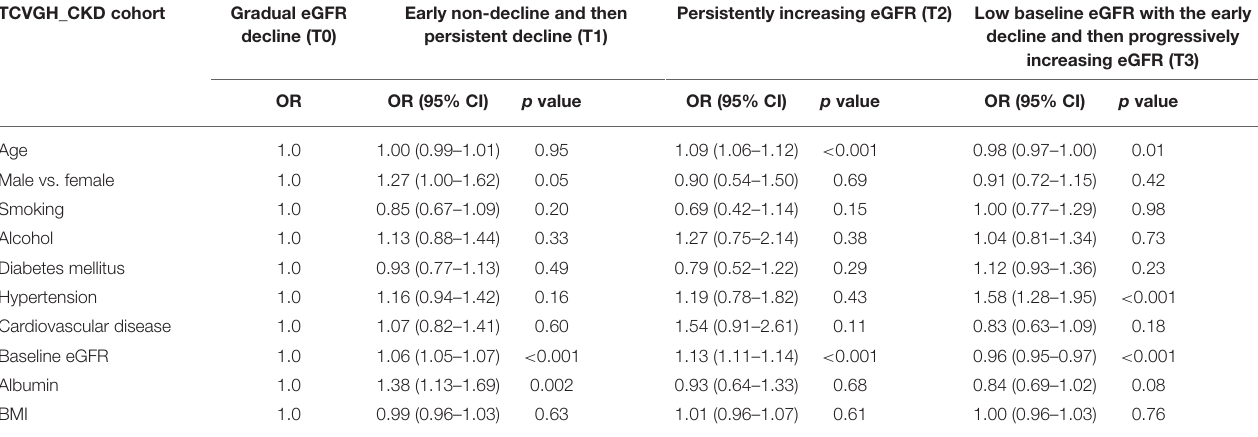
TABLE 2 | Multinomial logistic regression to evaluate the association of patients’ characteristics with different eGFR trajectory patterns.